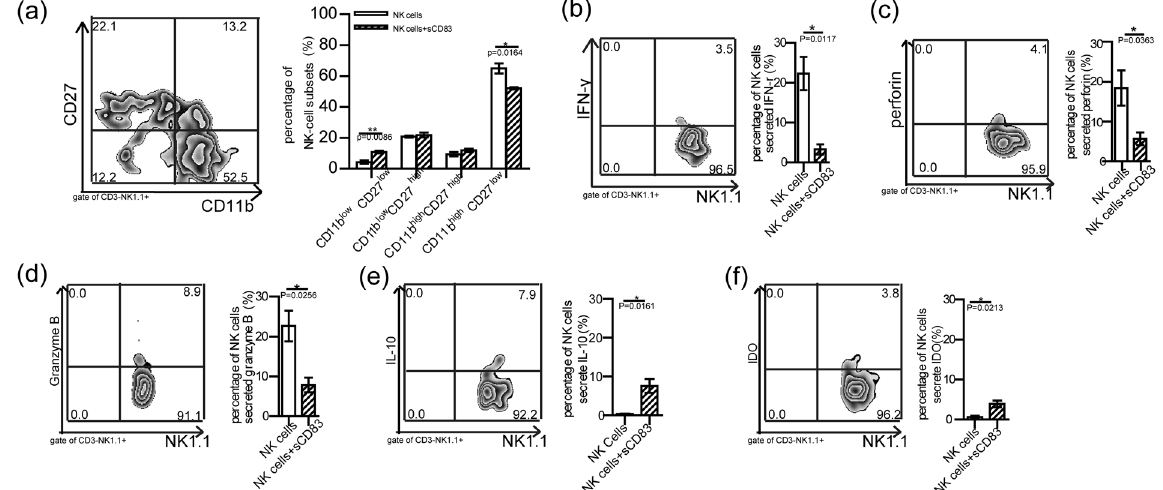
Figure 5. Mature subsets and functions of NK cells with sCD83 treatment were analyzed in-vitro . ( a ) Percent of individual NK cell-subsets in NK cells which were isolated from EAU mice with or without sCD83 treatment. ( b-f ). Percent of NK cells secreting IFN- γ ( b ), perforin ( c ), granzyme B ( d ), IL-10 ( e ) and IDO ( f ) following sCD83 treatment as assayed using flow cytometry (the experiments were replicated three times, values represent the mean ± s.e.m., * P < 0.05, ** P <